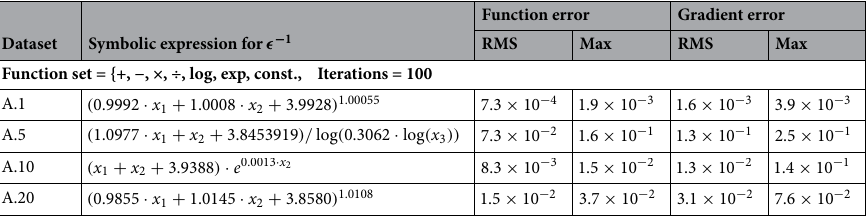
Table 4. Results from the symbolic regression analysis. From left to right the column indicate the name of the dataset from which the training data were sampled, the found symbolic expression corresponding for clarity 1 to ǫ − , the RMS and Max statistics of the relative error for the function and its gradient on a random sample of 6 10